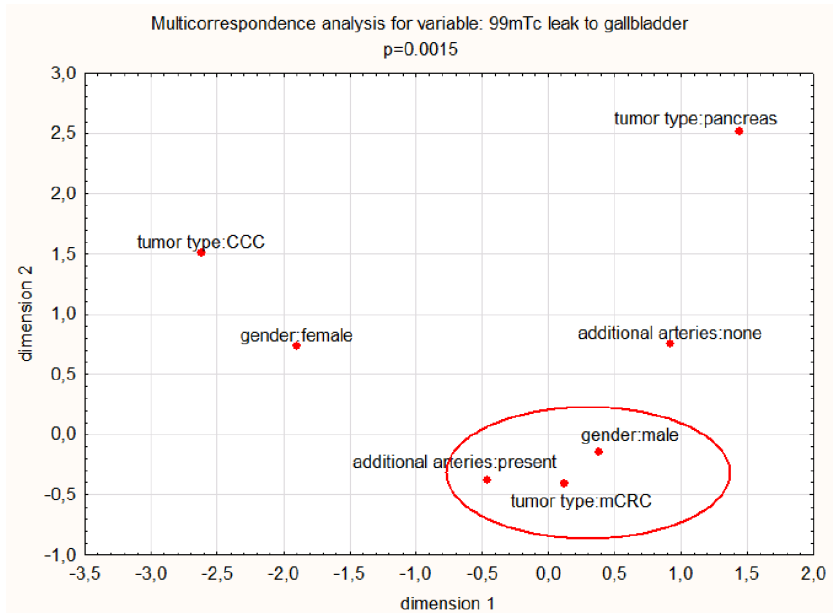
Figure 4. Flowchart presenting the sites of extrahepatic leaks in view of the site of injection.